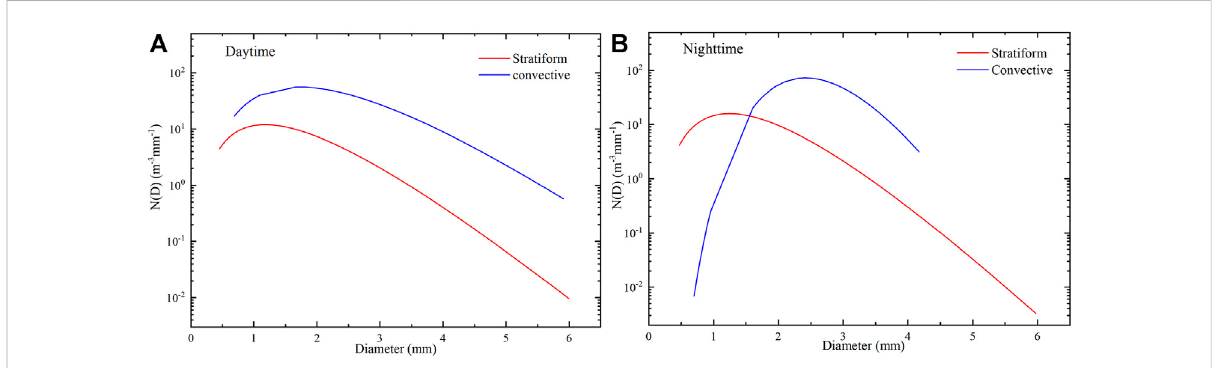
FIGURE 9 Average raindrop size spectra for the daytime (A) and nighttime (B) precipitation types in the head watershed at the head watershed of the Urumqi River. The solid red line and solid blue line represent stratiform and convective precipitation,